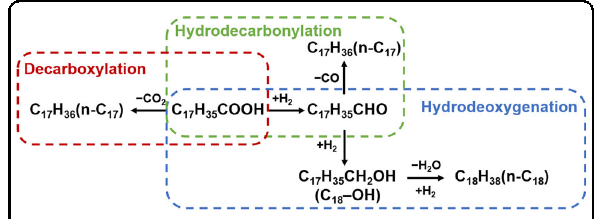
Scheme 1 The deoxygenation reaction of stearic acid for diesel